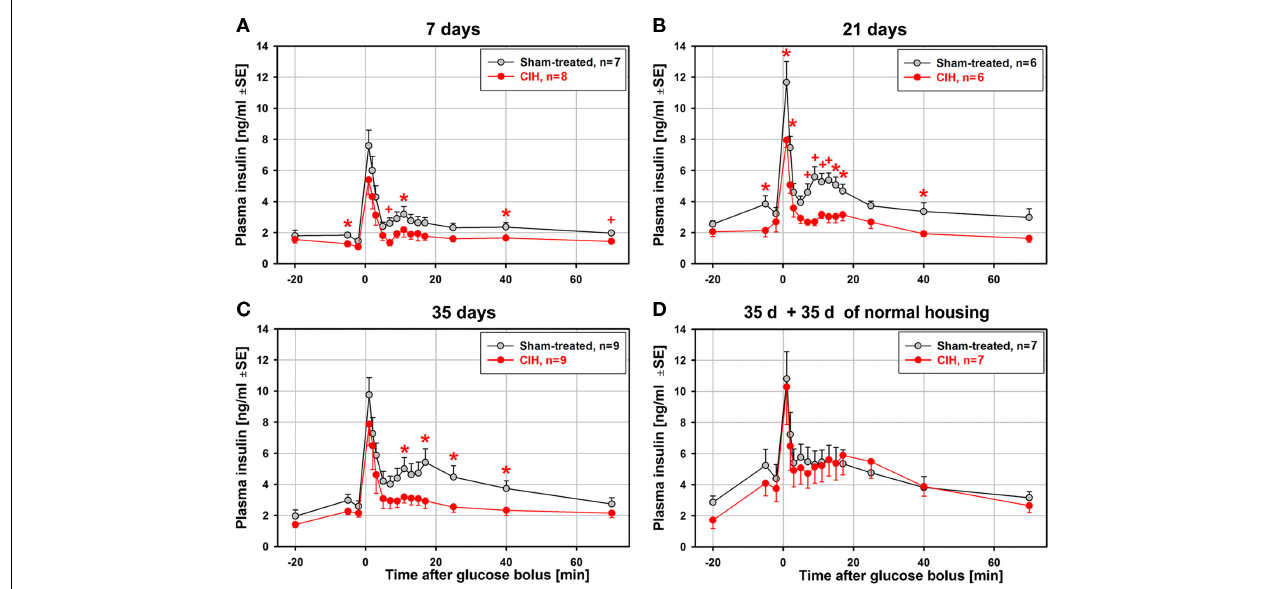
profound suppression of the second insulin peak in the CIH rats of all groups while the second insulin peak in the sham-treated rats increased with the duration of exposure. In the rats subjected to CIH or sham treatment for 35days and then housed normally for another 35days, glucose-stimulated insulin release did not differ between CIH and sham-exposed rats, with both groups having a distinct second peak of insulin release (D) . *, + Indicate p < 0.05 and p < 0.02, respectively, relative to the corresponding sham-treated group at the same time point. See text for further discussion.